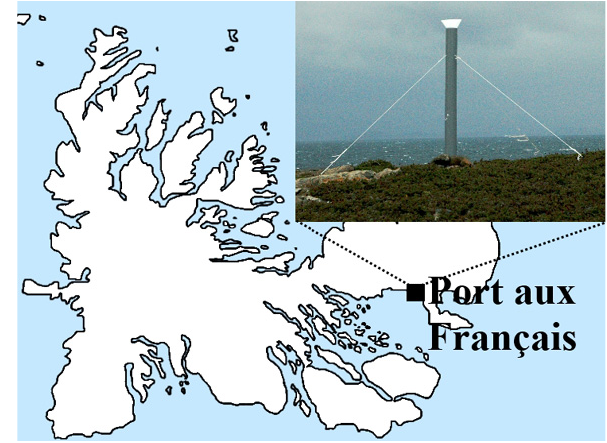
Fig. 1b. Port-aux-Français on the Kerguelen Islands plus picture of rainwater sampling device on